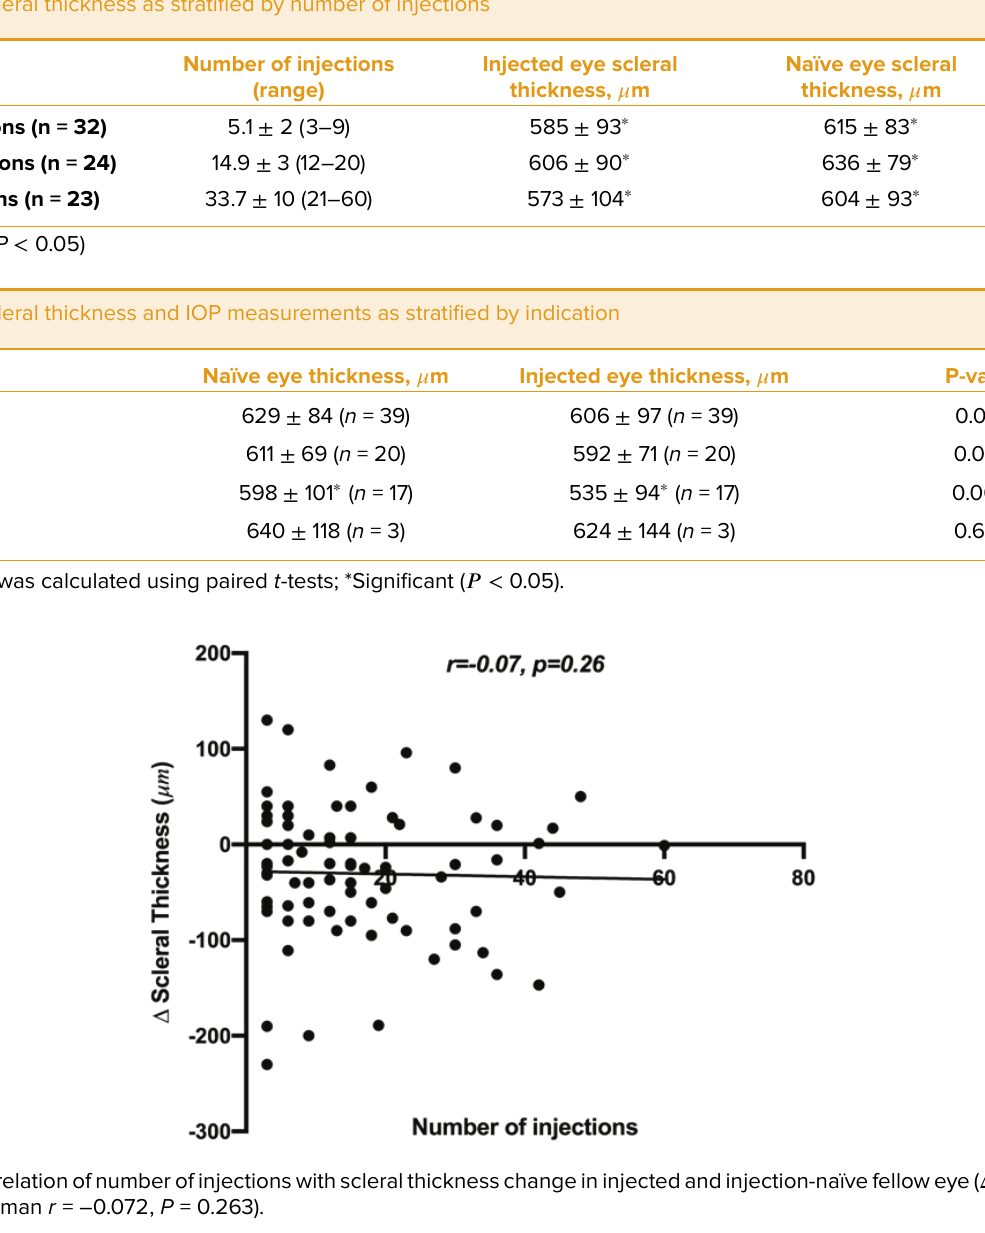
Table 3. Scleral thickness as stratified by number of injections